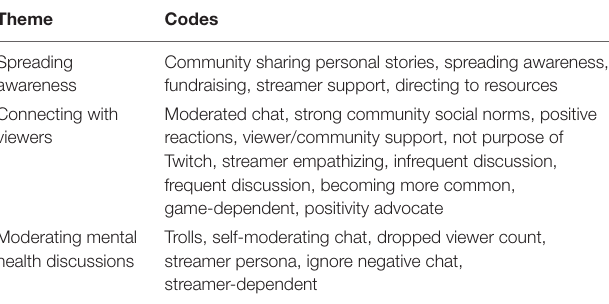
TABLE 3 | Coding breakdown for RQ2: how streamers facilitate mental health